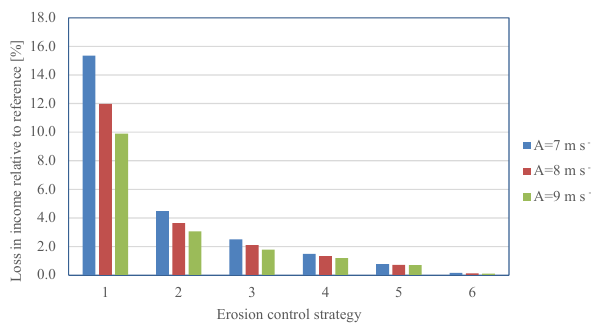
Figure 20. Loss of income due to erosion, inspection and repair. Energy: 250EURMWh − 1 . Repair: 10000EURrotor − 1 . Inspec- tion: 500EURrotor − 1 .